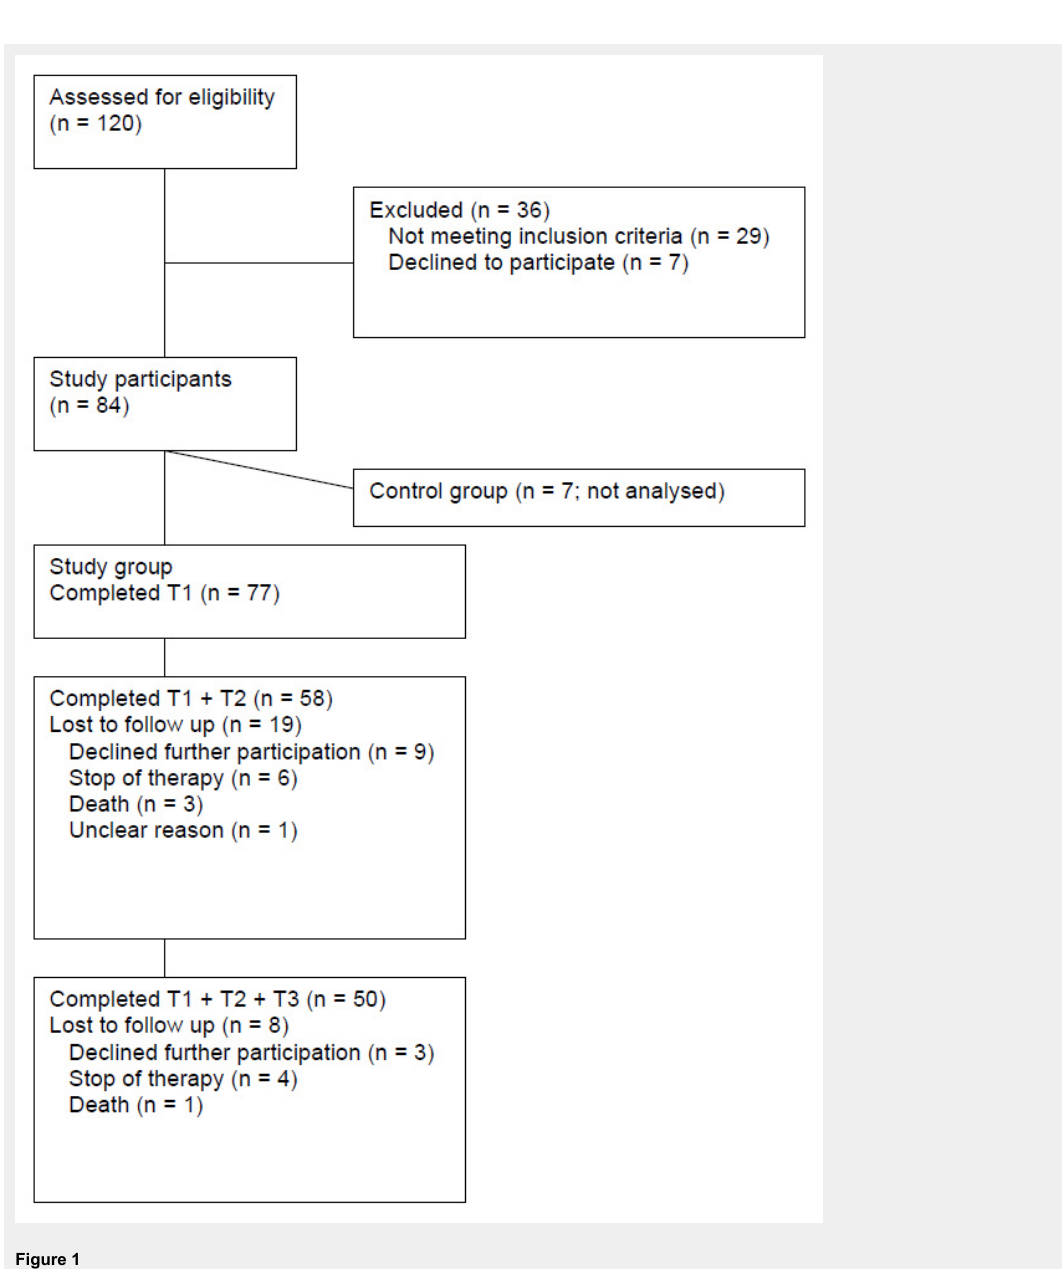
Figure 1 Overview of patient accrual and